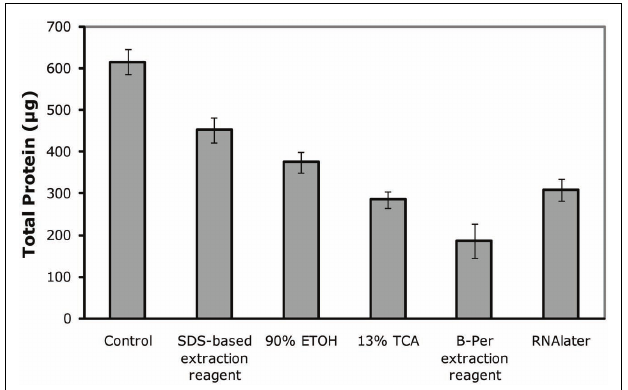
preservative details are listed in Table 1 . Error bars correspond to quadruplicate technical